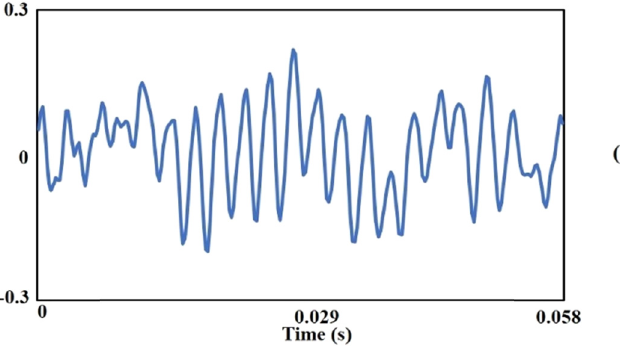
Figure 19: Frequency domain signal ( broken internal race ) .